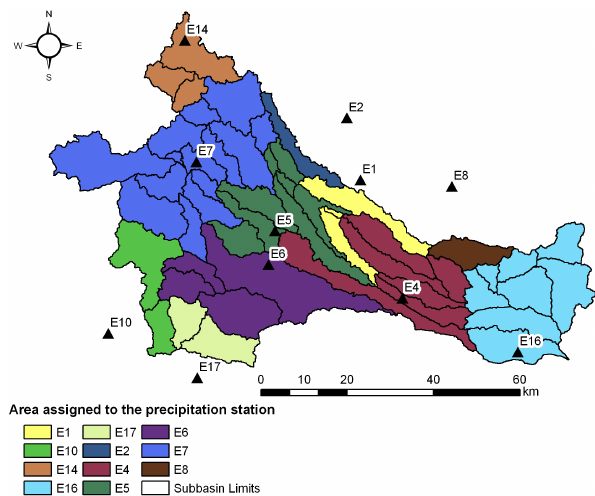
Fig. 5. Gauging stations in the watershed.